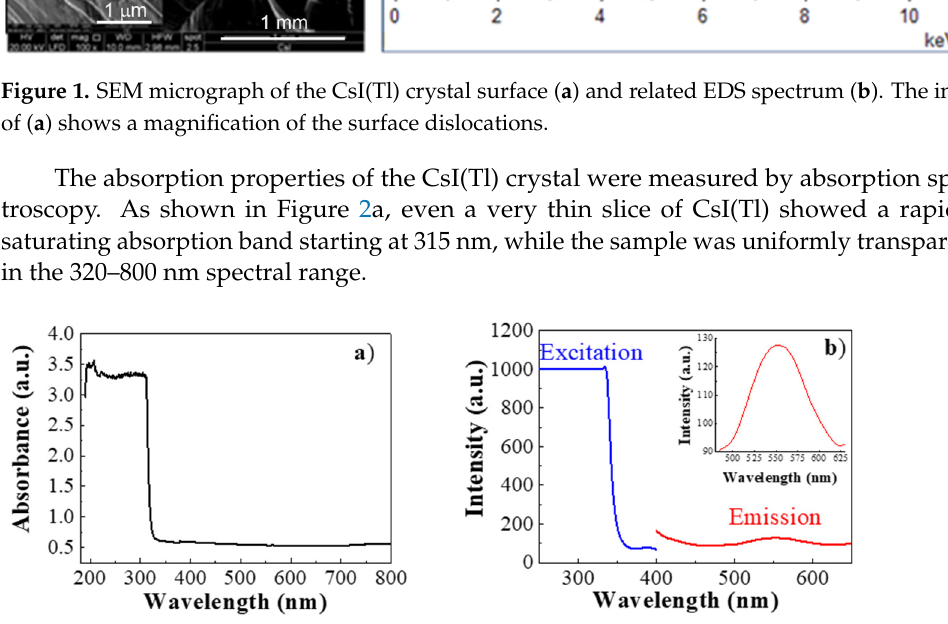
Figure 1. SEM micrograph of the CsI(Tl) crystal surface ( a ) and related EDS spectrum ( b ). The inset of ( a ) shows a magnification of the surface dislocations.